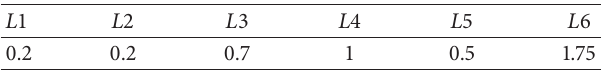
Table 1: Length of the cable in